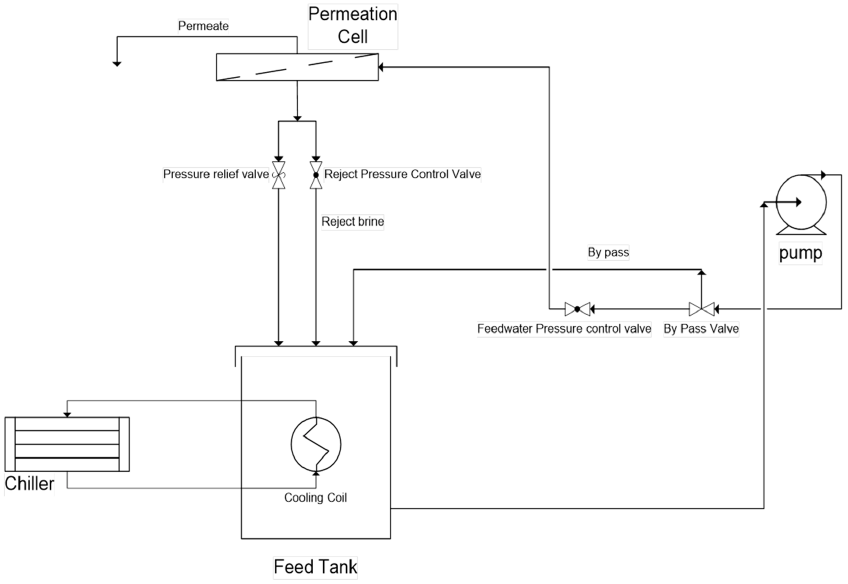
Figure 4. A diagrammatic representation of the cross-flow filtration system.